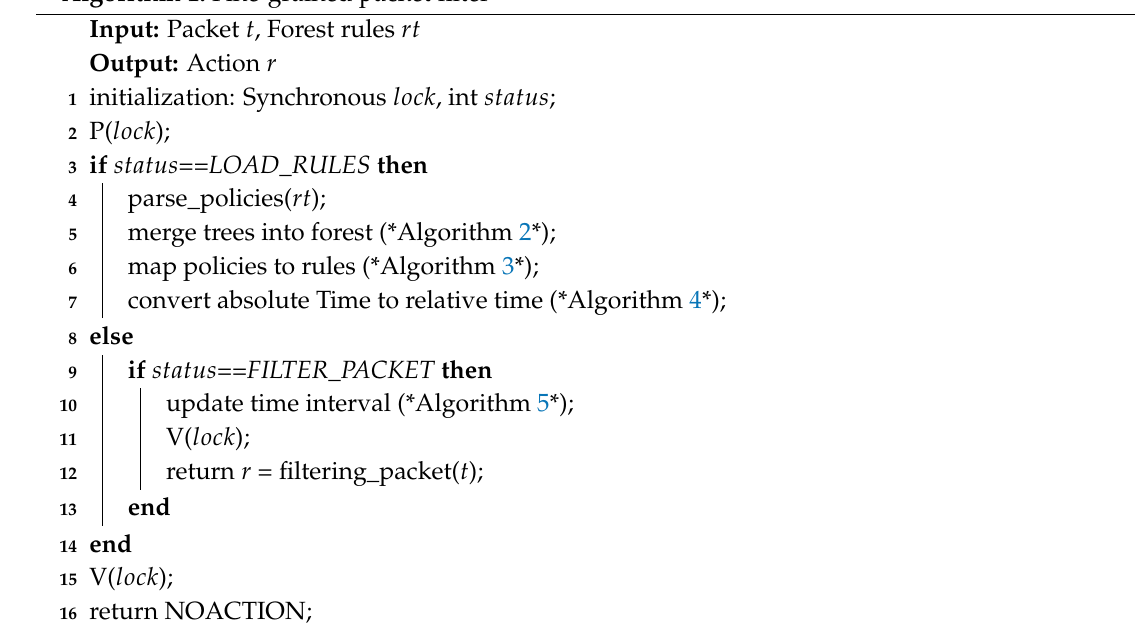
Algorithm 1: Fine-grained packet